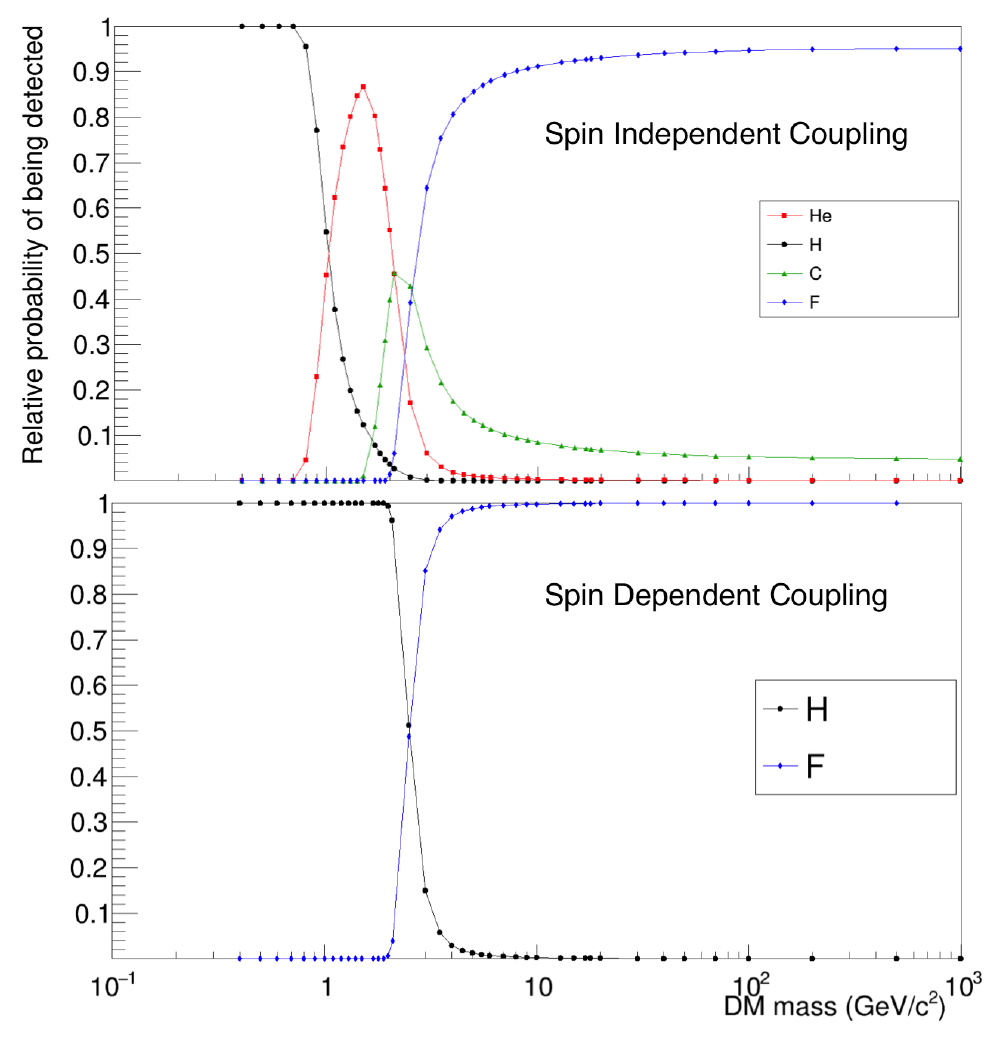
Figure 13. Relative probability of nuclear recoils being detected, given that a recoil was detected, as a function of the DM mass for the SI ( top ) and SD ( bottom ) couplings. An energy threshold of 1 keV ee was used, and the quenching factor corrections are